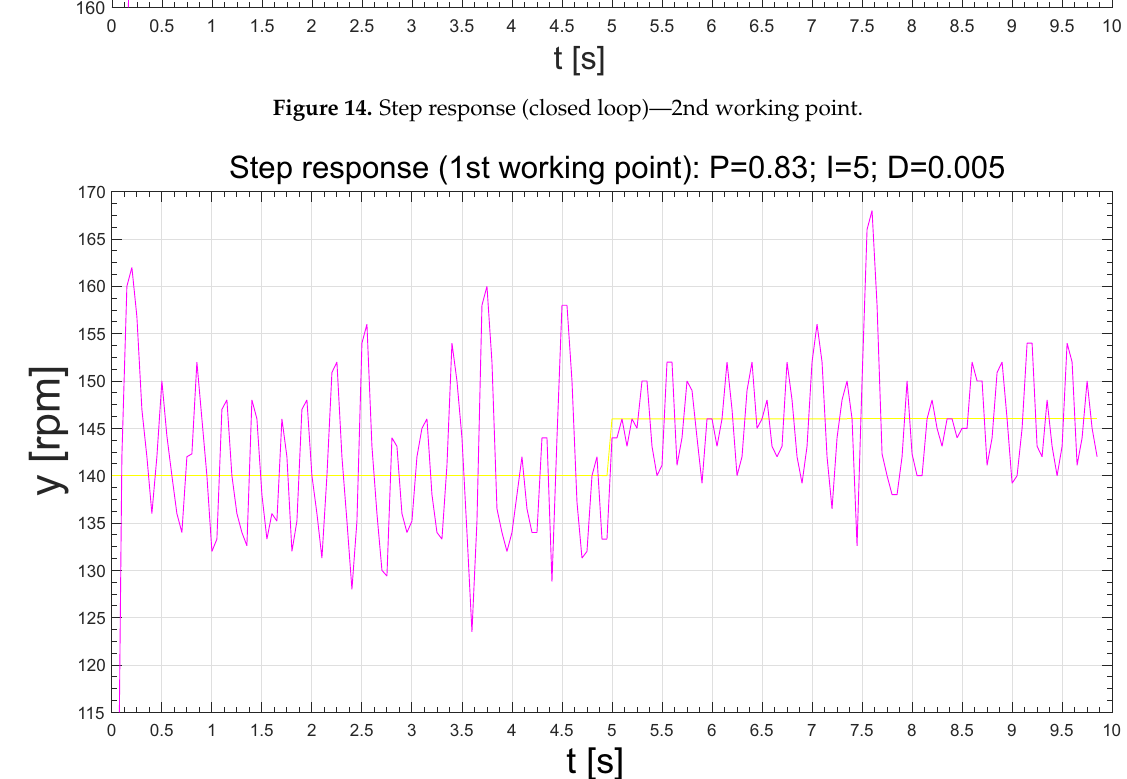
Figure 15. Step response (closed loop)—1st working point—with inappropriate